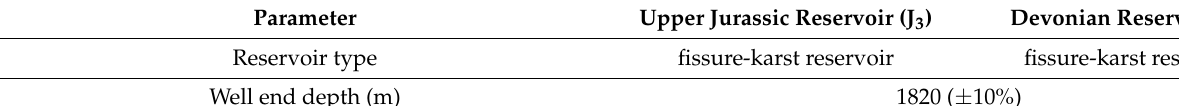
Well end depth (m) 1820 ( ± 10%) Aquifer interval depth, H (top/base) (m b.g.l.) Depth of the static water table (m b.g.l.)